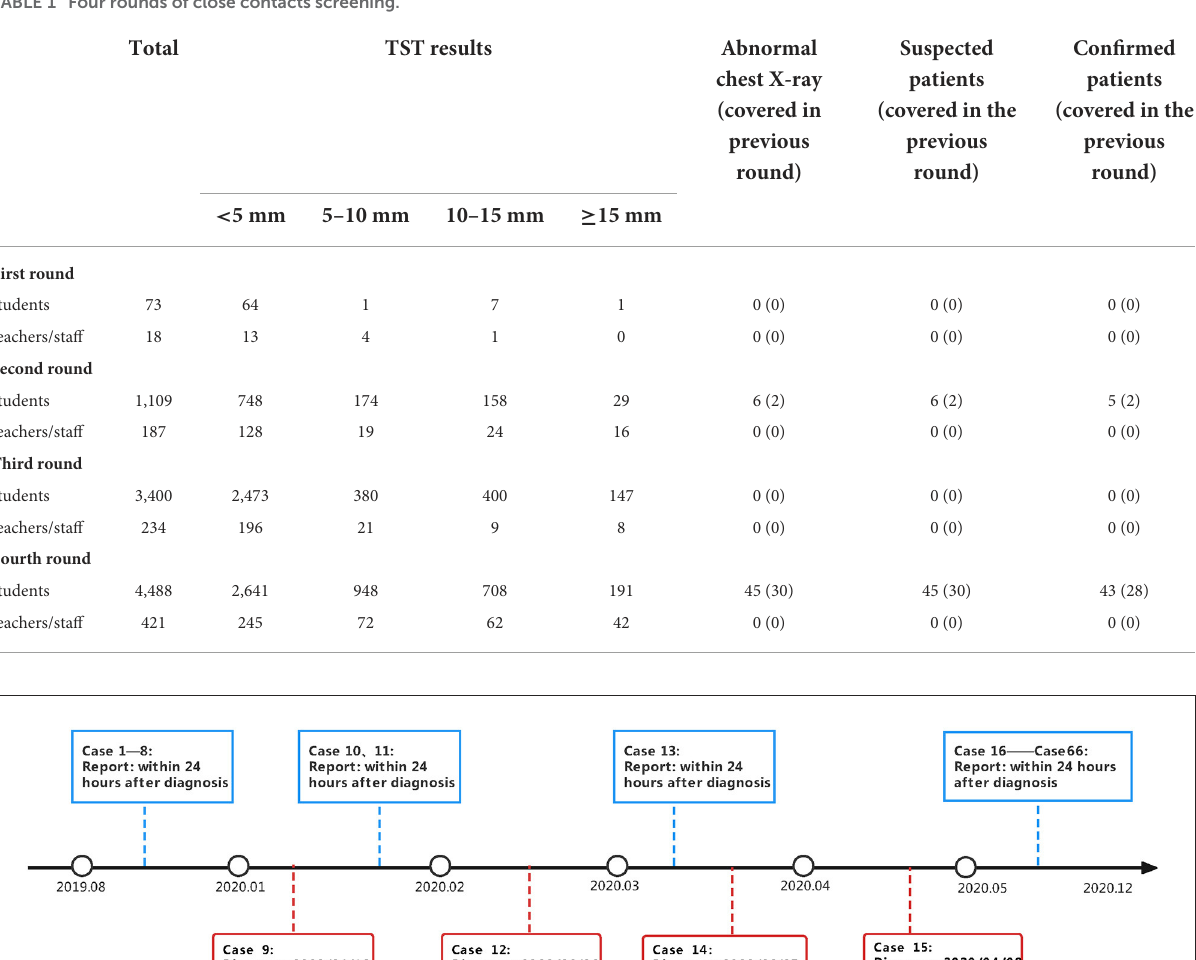
TABLE 1 Four rounds of close contacts screening.